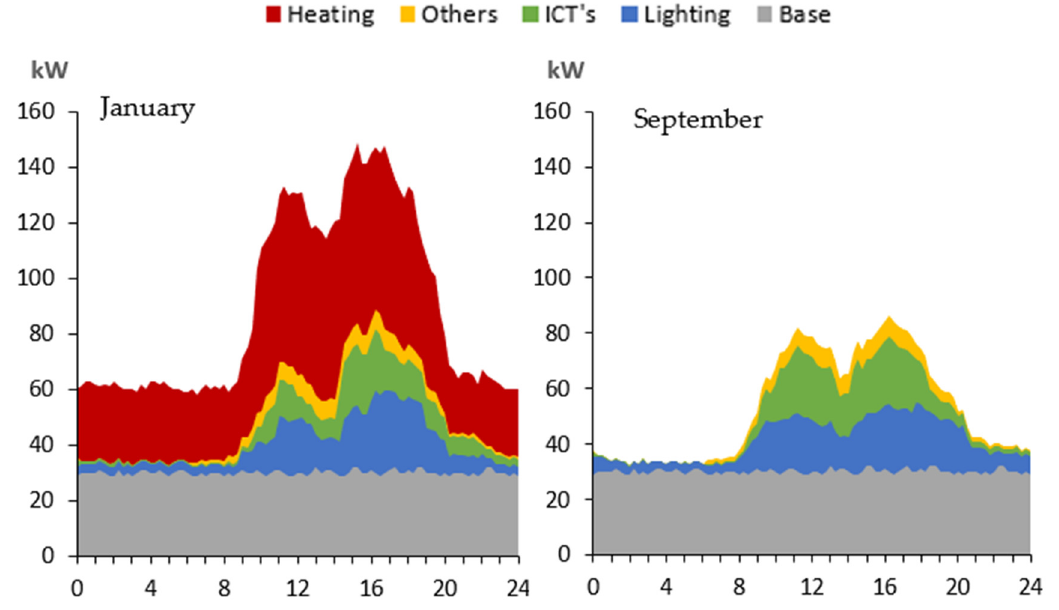
Figure 3. Comparison between the load diagrams in January and September.